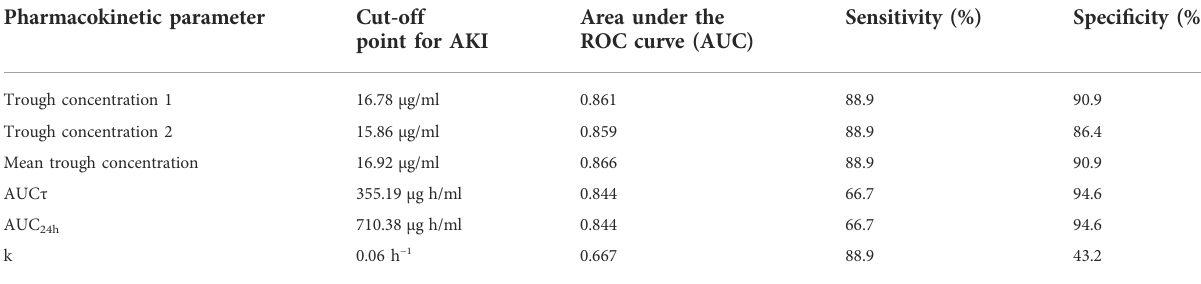
TABLE 7 Trough concentration and AUC cut-off points for AKI occurrence and the reported area under the ROC curve values. Pharmacokinetic